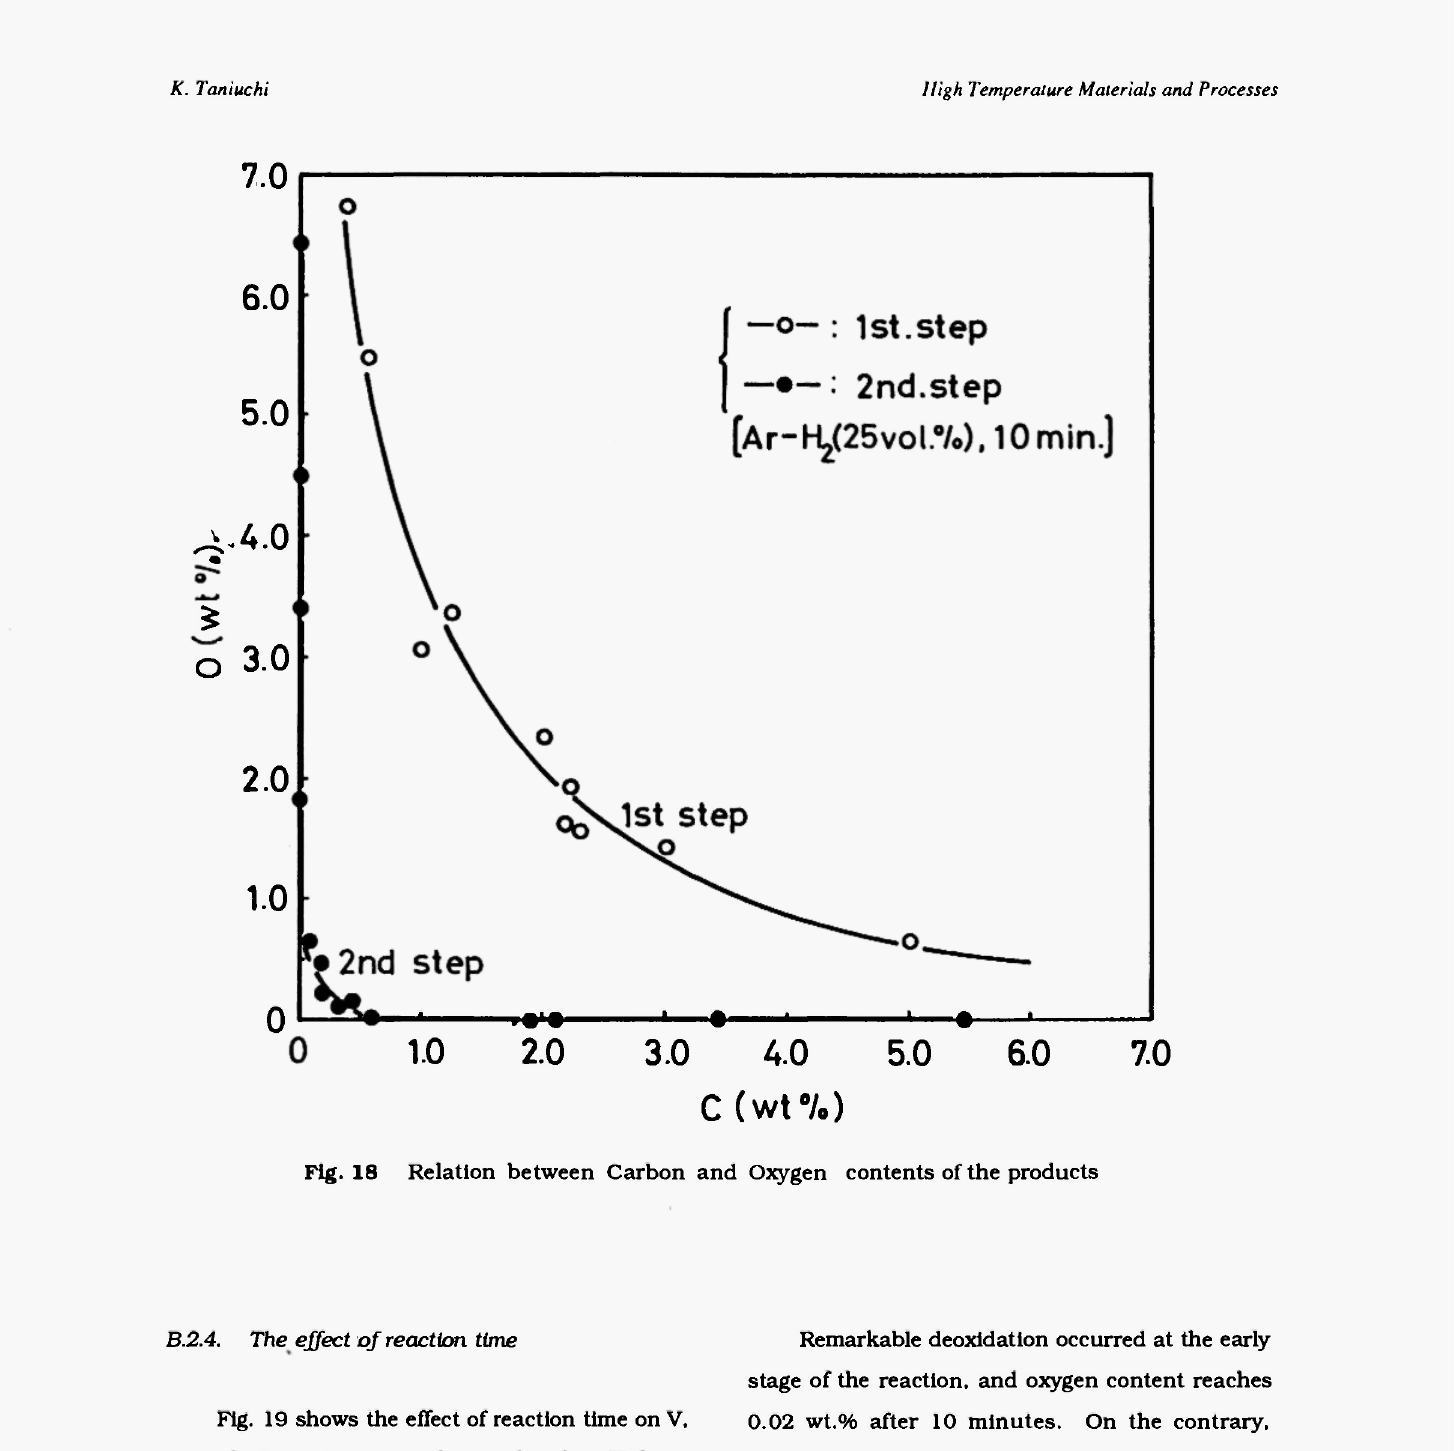
Relation between Carbon and Oxygen contents of the